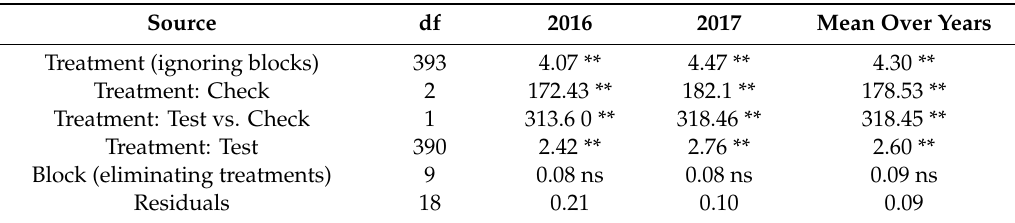
Table 1. Analysis of variance and mean sum of squares of augmented block design for brown planthopper scoring of the 391RiMi panel.